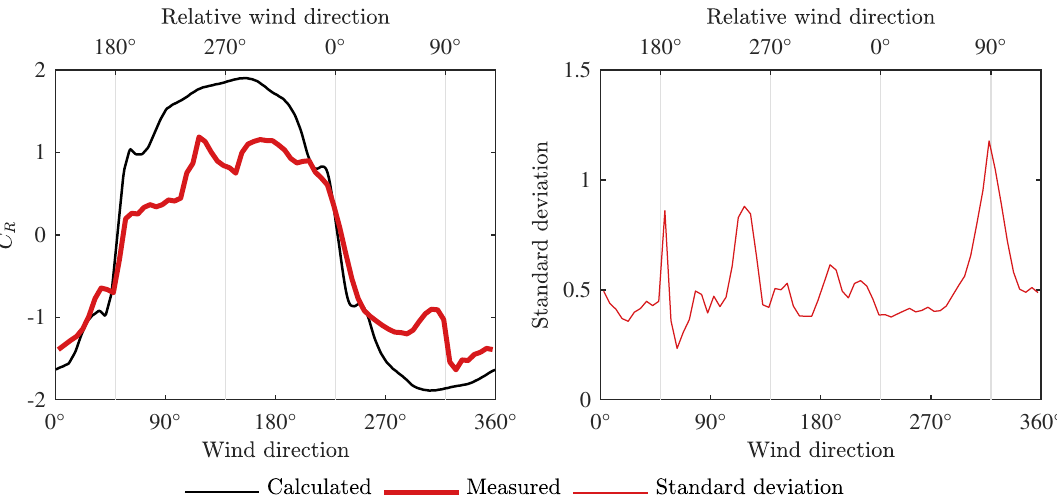
Figure 8. Left : Comparison of measured and calculated forces in the radial direction. Right : Standard deviation of the measurements.